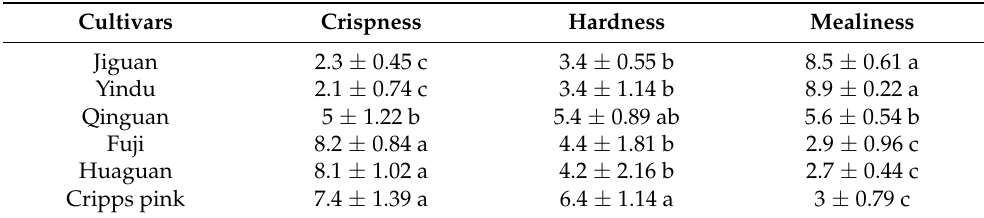
Table 1. Sensory evaluation of the ‘Jiguan’, ‘Yindu’, ‘Qinguan’, ‘Fuji’, ‘Huaguan’, and ‘Cripps pink’ apple fruit stored at 25 ± 1 ◦ C at 40 DAH. Data are presented as mean ± standard error (SE) from ten judges; in each property, the letters behind the numbers indicate significant differences ( p < 0.05) between six